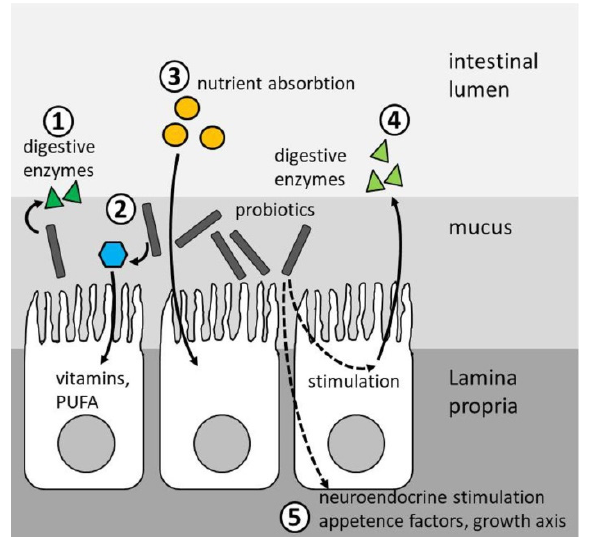
Figure 2. Nutrition- and growth-related effects (modes of action) of probiotics in the gastrointestinal tract (GIT), including direct effects such as (1) secretion of digestive enzymes; (2) absorption of (micro)nutrients such as cofactors, vitamins, and polyunsaturated fatty acids; (3) indirect effects, including elevated nutrient uptake/absorption; (4) stimulation of enzyme secretion, as well as (5) neuroendocrine stimulation of appetence and growth. For further details, refer to the text.